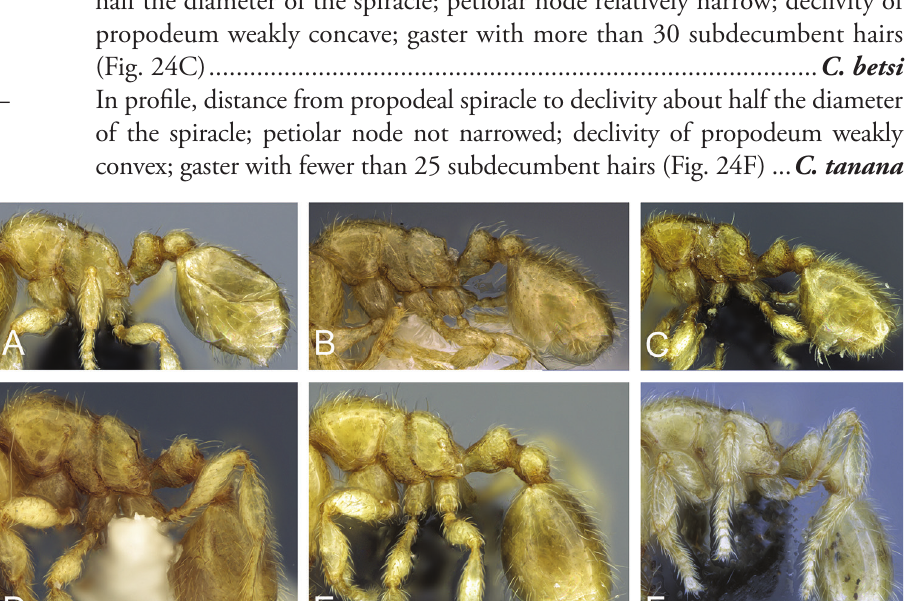
form angle (Fig. 24C, E, F) ......................................................................... 9 9 24E) ................................................................................................. C. bara